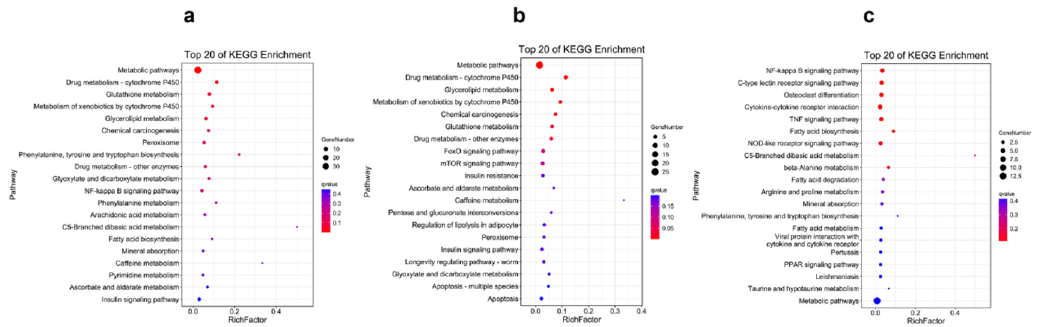
Figure 3. The Top 20 KEGG Pathways Enriched by the Differentially Expressed Genes in the Liver at 12 h Postinjection: ( a ) the Top 20 Enrichment Pathways among All Differentially Expressed Genes; ( b ) the Top 20 Enrichment Pathways among the Upregulated Differentially Expressed Genes; ( c ) the Top 20 Enrichment Pathways among the Downregulated Differentially Expressed Genes.